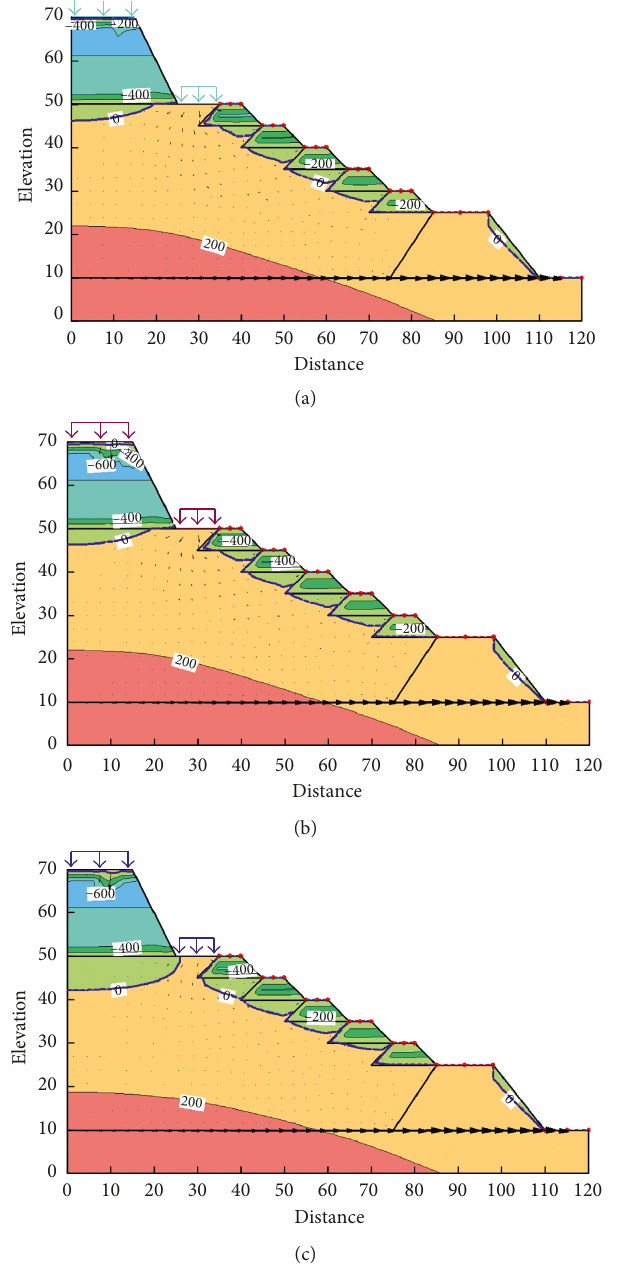
Figure 10: Pore water pressure distribution of red mud stockpile seepage field under different rainfall conditions: (a) rainfall con- dition I, (b) rainfall condition II, and (c) rainfall condition III.